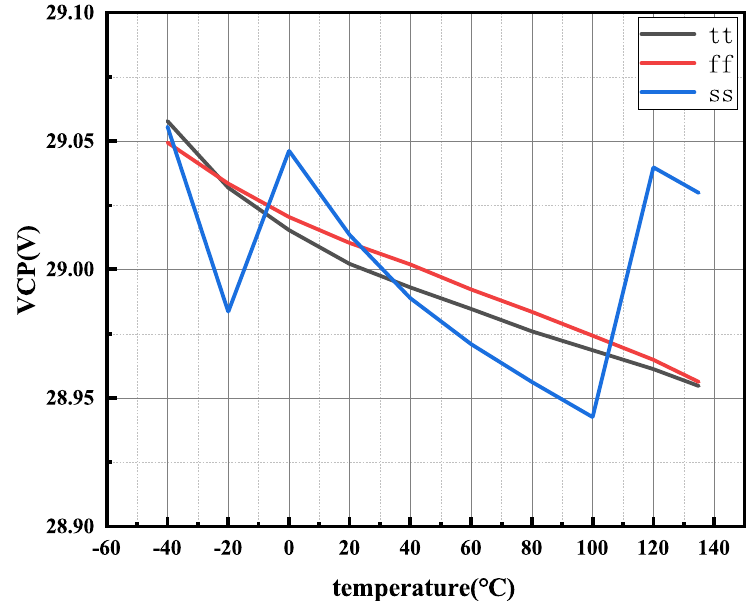
Figure 7. Output voltage VCP when A1A2 = 00, VBB = 24 V.